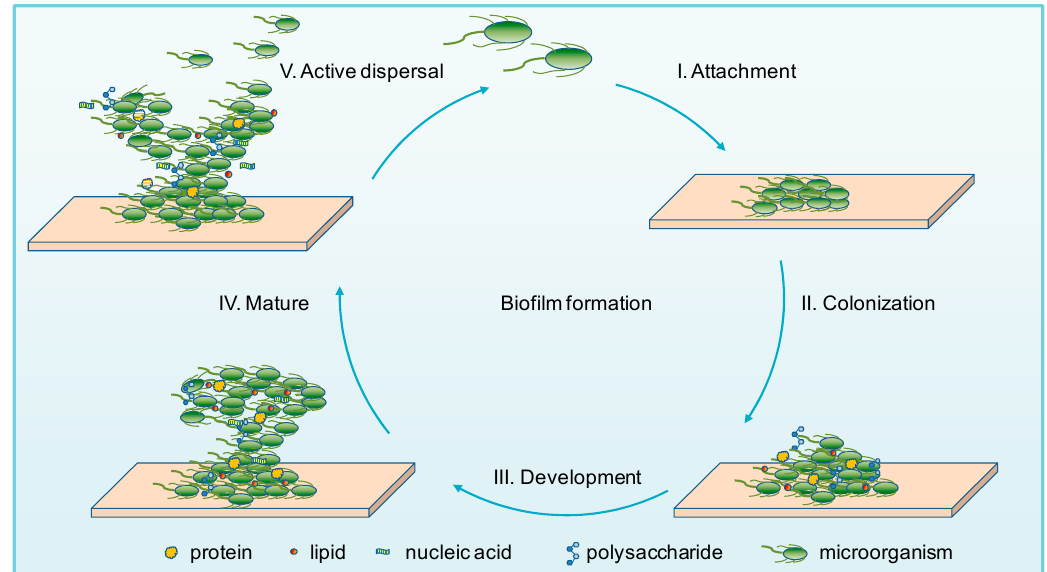
Figure 1. Model of microbial biofilm formation. Biofilm formation consists of five distinct stages: I. Attachment: microbial cells adhere to the surface reversibly. II. Colonization: microbial cells attach to the surface irreversibly via flagella, pili, exopolysaccharides, etc. III. Development: multilayered cells accumulate and produce extracellular polymeric substances (EPS). IV. Mature: stable formation of a three-dimensional community. V. Active dispersal: microorganisms are disseminated from the aggregate biofilm and return to a planktonic state.